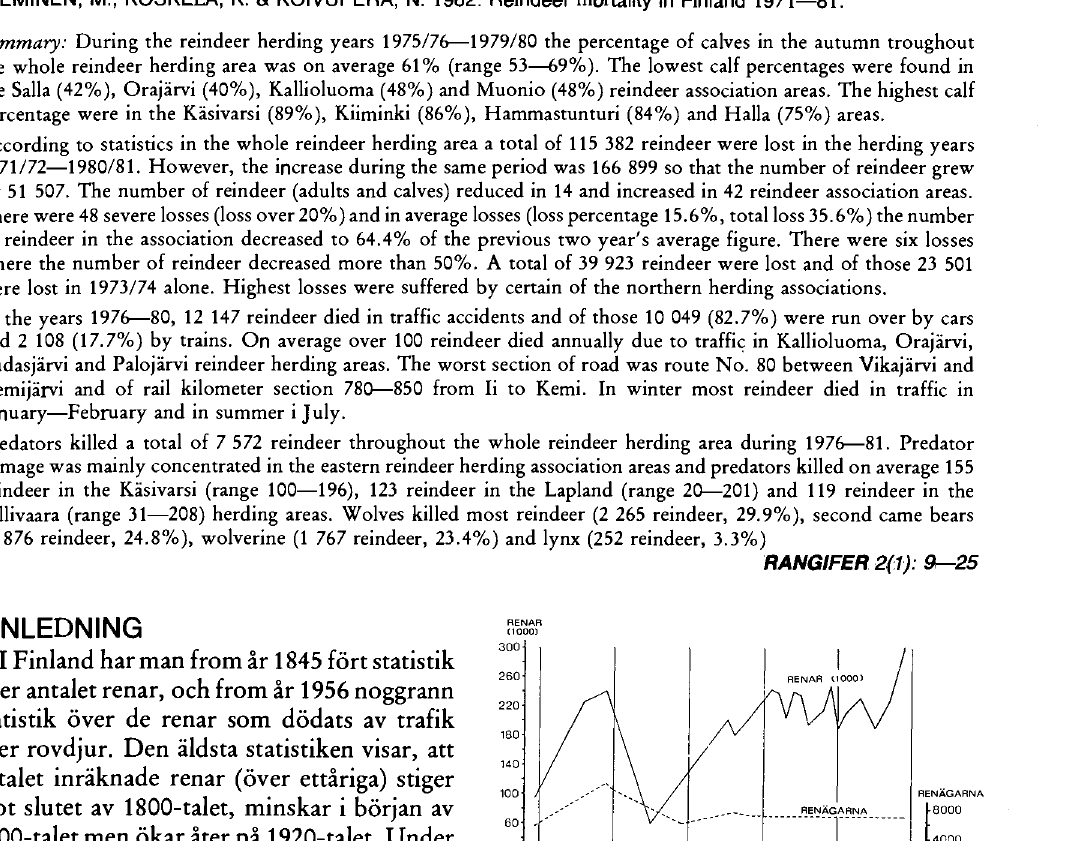
Fig. 1. Gross number of reindeer in Finland (renar) and reindeer